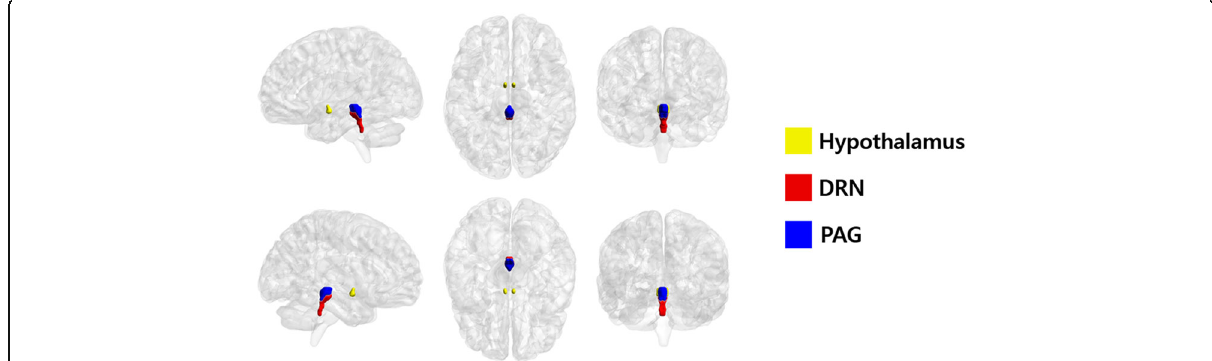
Fig. 1 Region of interest segmentation results. The hypothalamus, dorsal raphe nuclei (DRN), and periaqueductal gray (PAG) were segmented on a three-dimensional brain